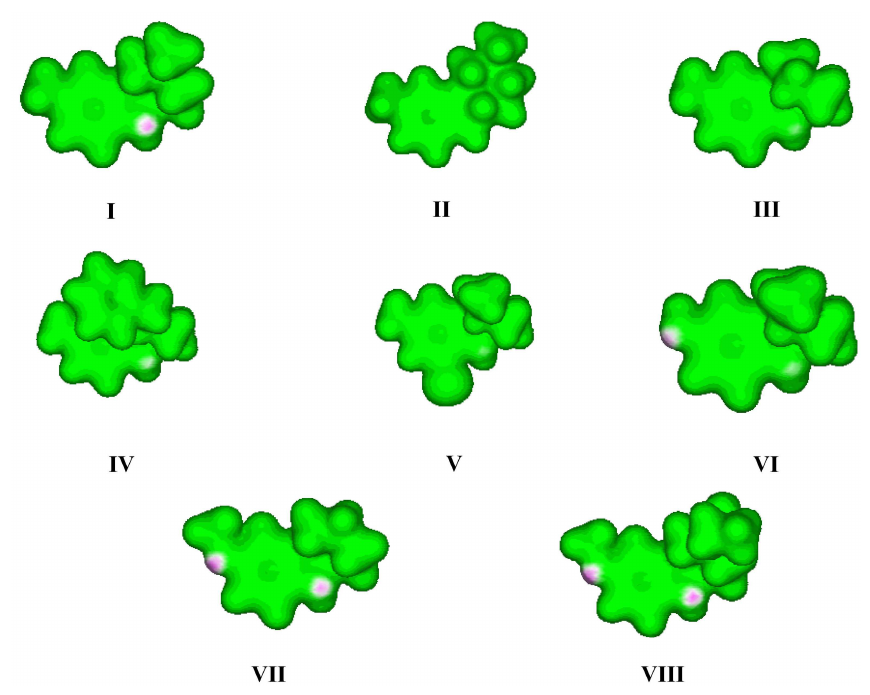
Fig. 3 Molecular electrostatic potential maps of the compounds